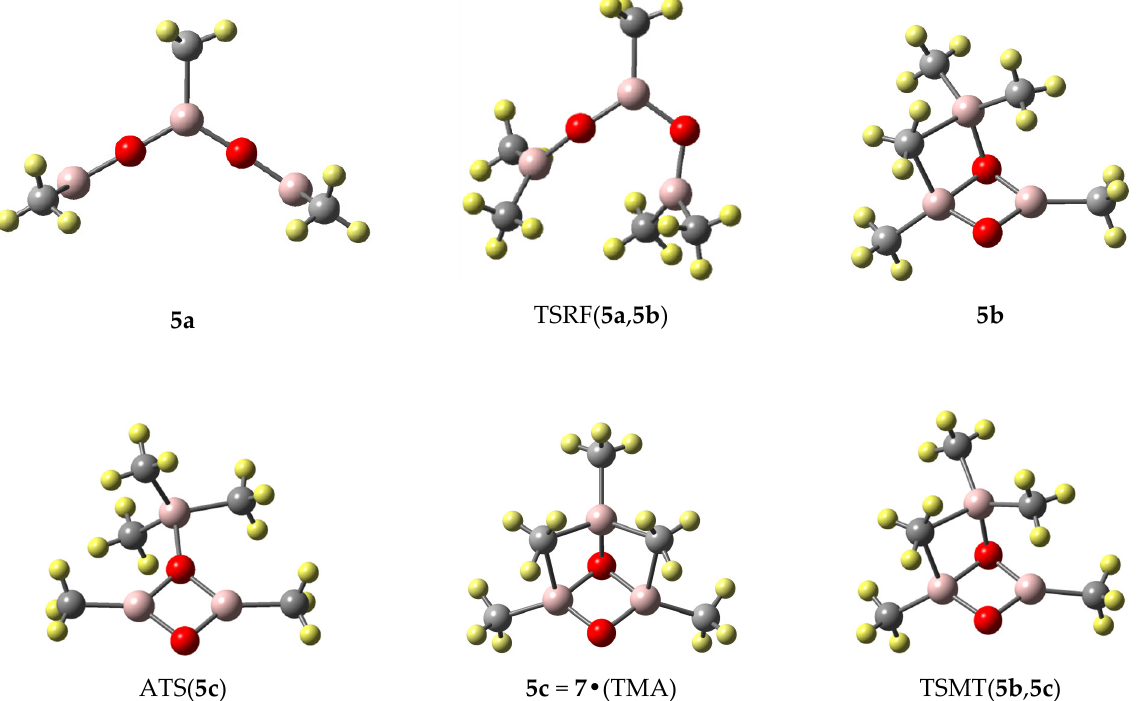
Figure 1. MP2/6-31G* optimized structures of permethyltrialuminoxane 5 : Acyclic allene structure 5a , cyclic, monobridged structure 5b , and cyclic, dibridged structure 5c . Also shown are the computed structures of the transition state structures TSRF( 5a , 5b ) for ring formation, of the transition state structure TSMT( 5b , 5c ) for methyl transfer between 5b and 5c , and of the transition state structure ATS( 5c ) for automerization 5c ⇄ 5c .